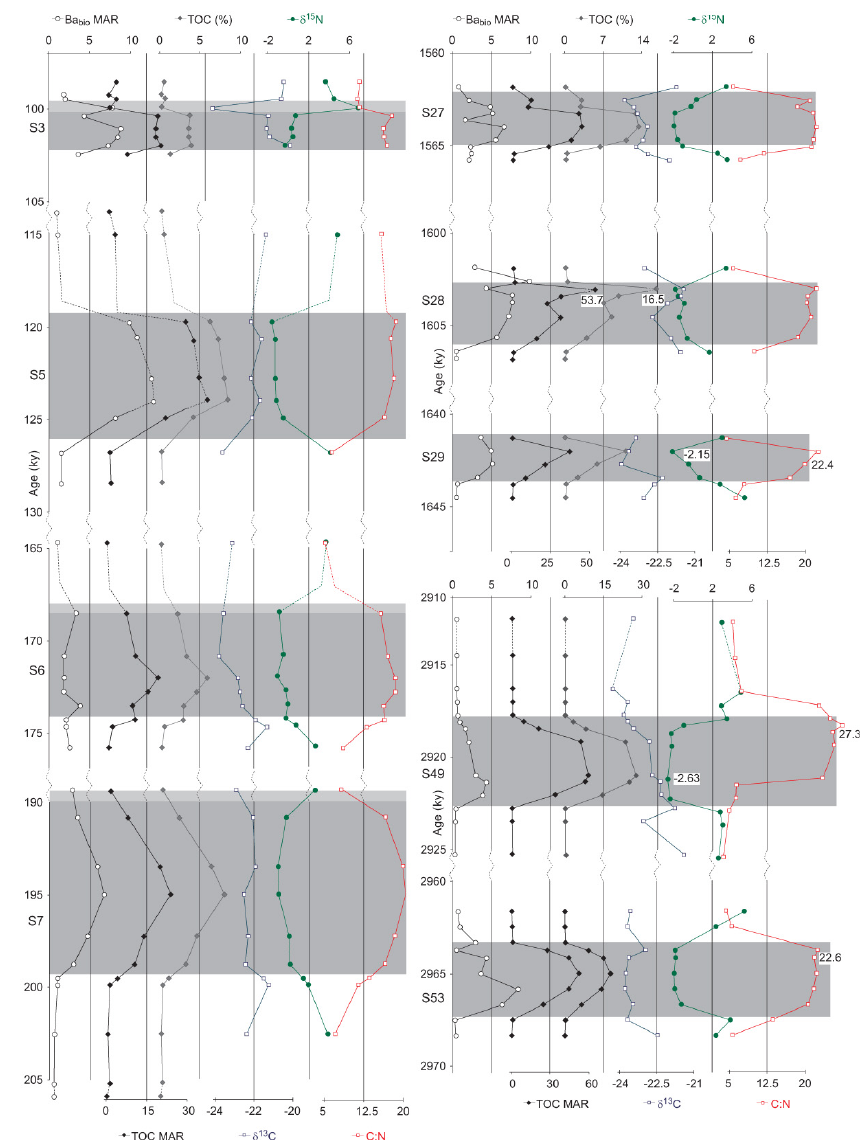
Fig. 11. Temporal evolution of the depositional conditions from Pliocene to Pleistocene, represented by TOC, Ba bio -MAR, N and C isotopic composition and C:N ratio on the Mediterranean Ridge (Site 969). For Holocene sapropel, see Figs. 2 and 6. Maximum off-scale values are numerically indicated in the